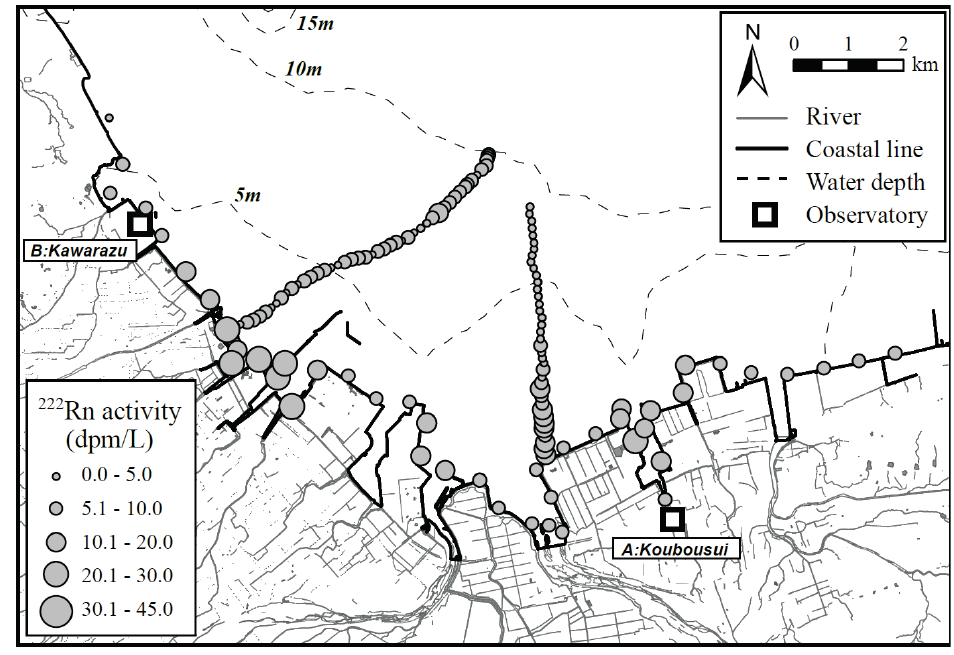
Fig. 5 222 Rn distribution (dpm/L) in July